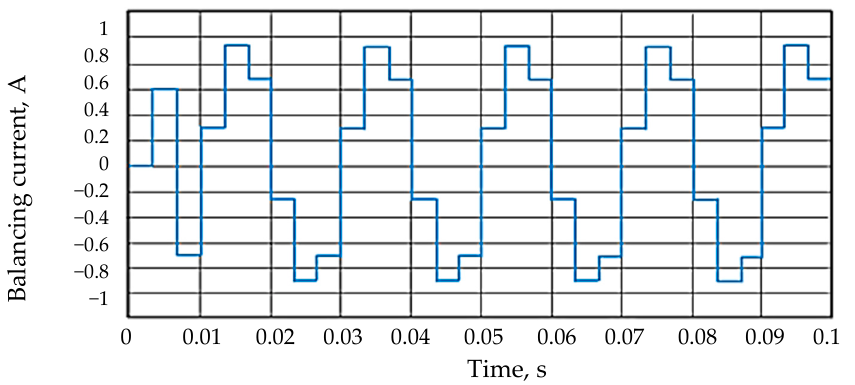
Figure 8. The current of symmetry.